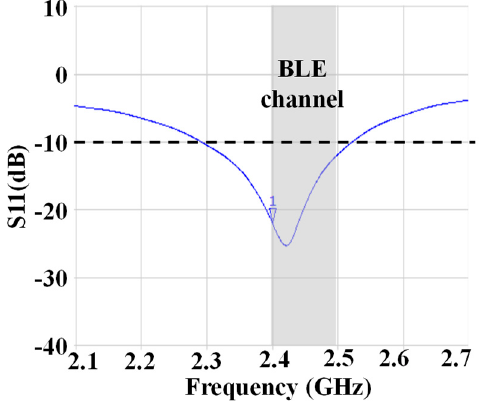
Figure 23. The measurement result of S 11 characteristics of the proposed transceiver.